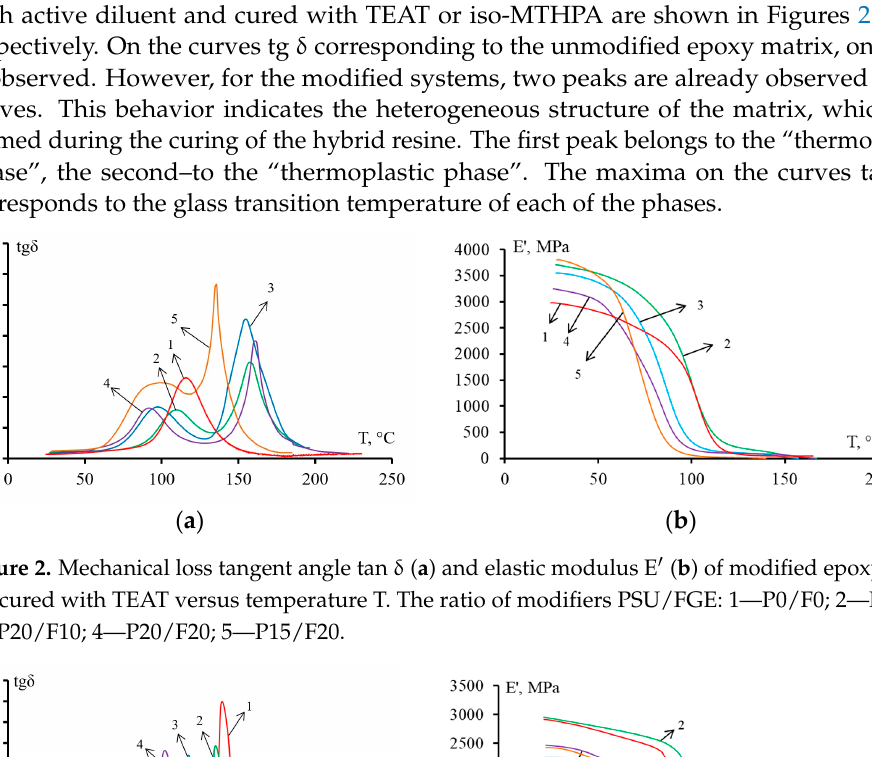
Figure 2. Mechanical loss tangent angle tan δ ( a ) and elastic modulus E’ ( b ) of modified epoxy matrices cured with TEAT versus temperature T. The ratio of modifiers PSU/FGE: 1–P0/F0; 2–P20/F0; 3–P20/F10; 4–P20/F20; 5–P15/F20.